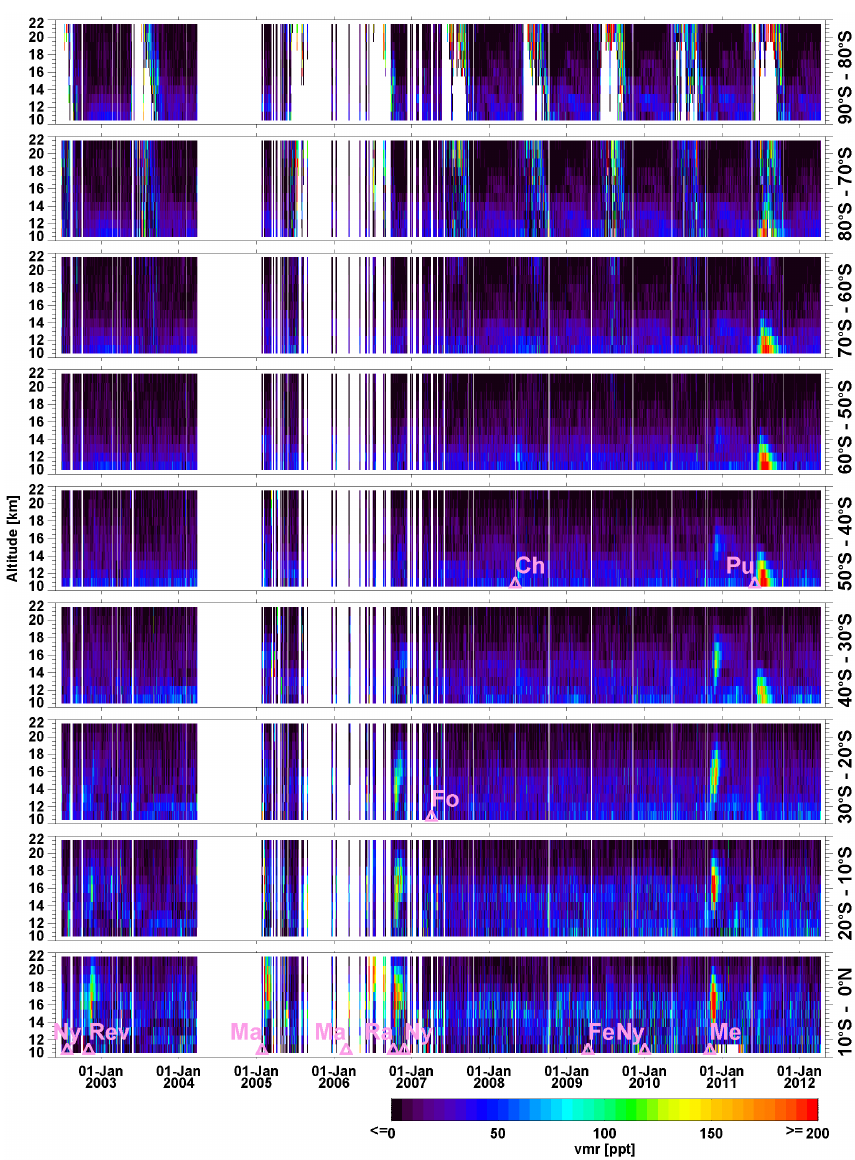
Figure 11. Time series of colour-coded SO 2 volume mixing ratio profiles for 10 ◦ latitude bins in the Southern Hemisphere with a time resolution of 2 days. The colour scale is restricted to 0–200pptv: negative and values larger than 200pptv are given the colour belonging to 0 and 200pptv respectively. Volcanic eruptions are indicated at the latitude bin of their location (for details see Table